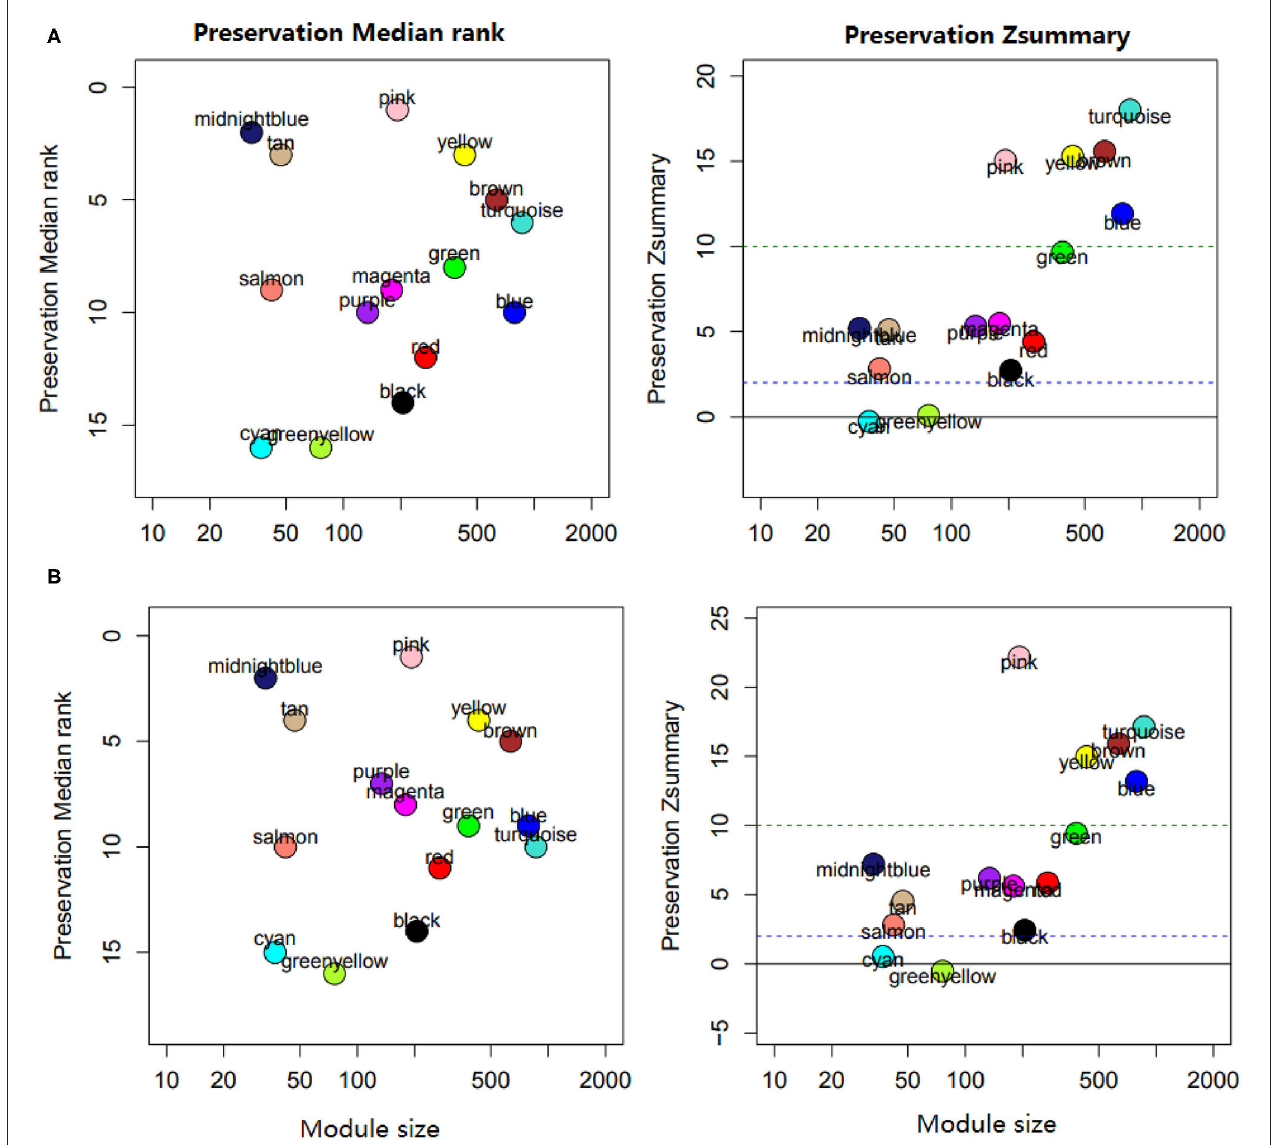
FIGURE 5 | Module preservation analysis. (A) Modules preserved in E. acervulina. (B) Modules preserved in E. maxima